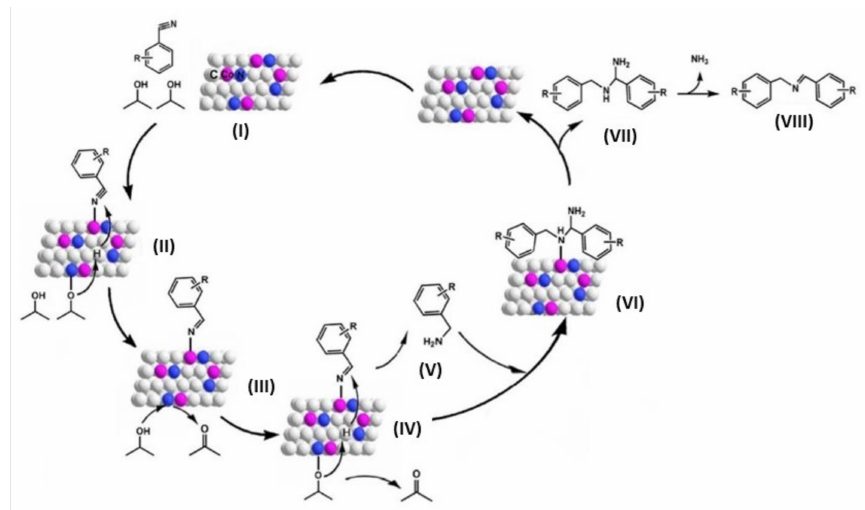
Scheme 10. Proposed reaction mechanism for the transfer hydrogenation of nitriles to primary amines and imines. Reproduced with permission from ref. [133]. Copyright © 2017,